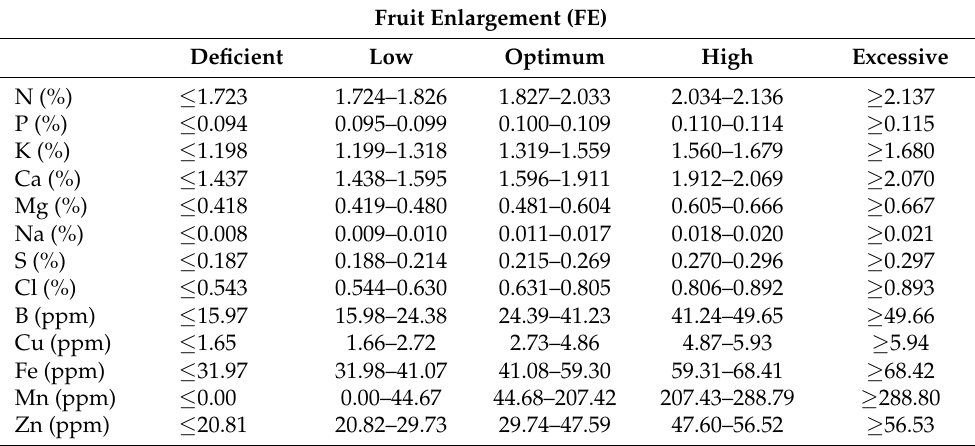
Table 5. Nutrient optimal range (NOR) in the FE stage of persimmon fruit in PDO ‘Kaki Ribera del X ú quer’, Spain.